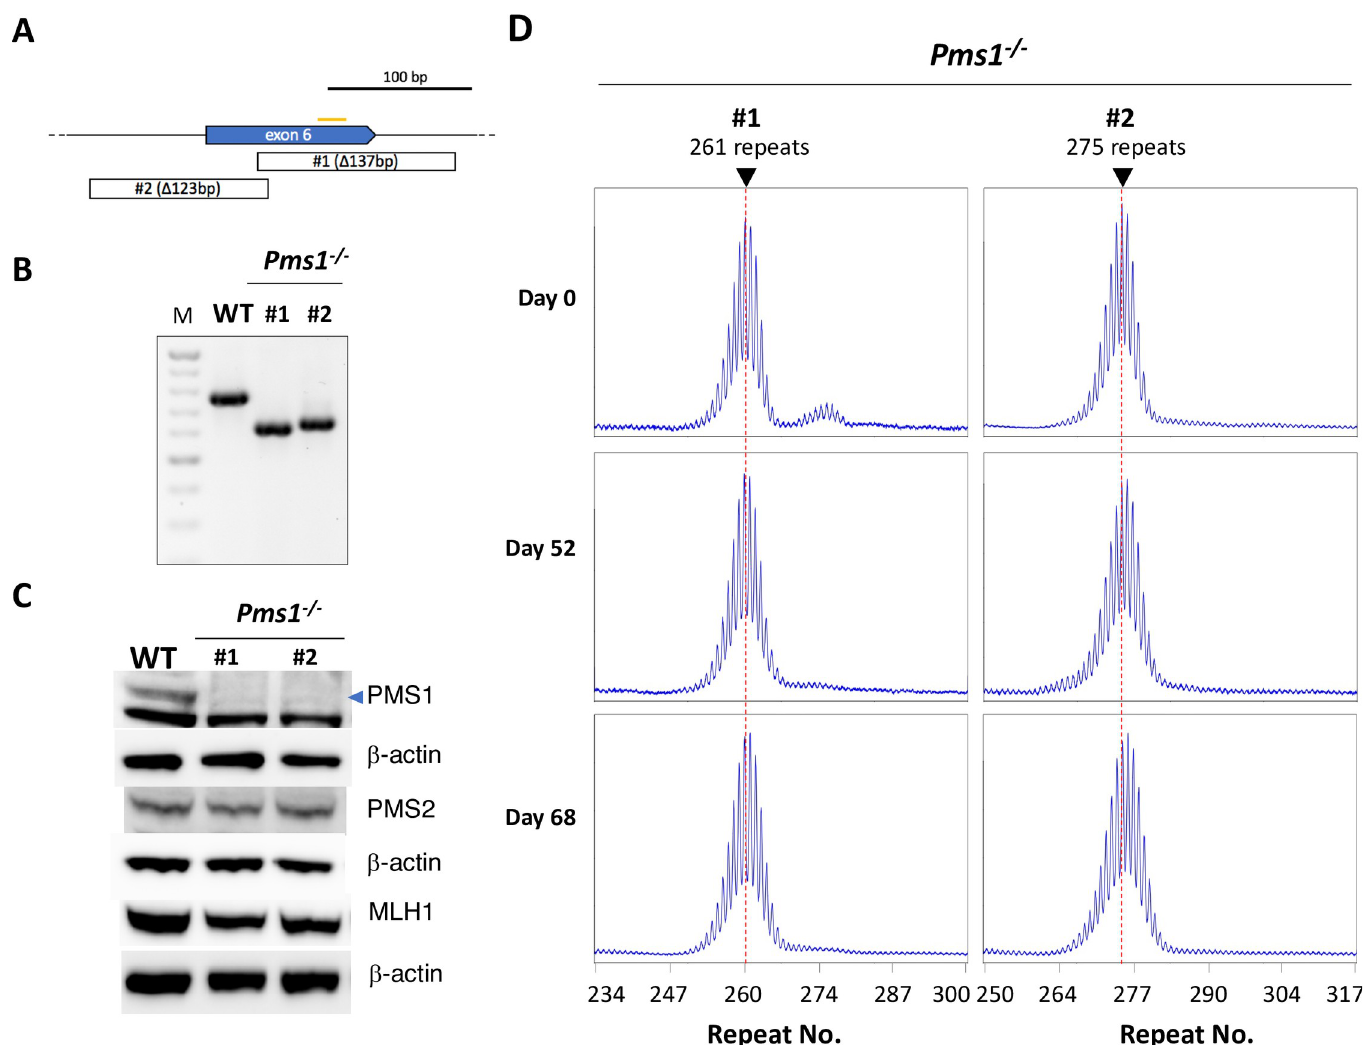
Fig 5. Generation and analysis of Pms1 -/- cell lines. A) Diagram of mutations generated in exon 6 of Pms1 . Orange bar: CRISPR gRNA target. Open boxes: extent of CRISPR-induced deletion in the indicated lines. B) PCR analysis of DNA from Pms1 +/+ cells and the two Pms1 -/- CRISPant cell lines shown in panel A. M: 100 bp molecular weight ladder. C) Western blot showing the deficit of PMS1 in the edited lines and that the loss of PMS1 does not affect the levels of MLH1 or PMS2. Note a) that the faint band apparent in the Pms1 -/- lanes of the PMS1 blot corresponds to the smaller of the two closely migrating bands seen in Pms1 +/+ lines and b) that the lanes from the MLH1 western blot shown here are from the same blot shown in Figs 2C and 4C. D) Repeat PCR profiles of the two Pms1 mutant lines after 0, 52 and 68 days in culture. The red dotted line on each profile indicates the major allele present in the cell population at day 0.